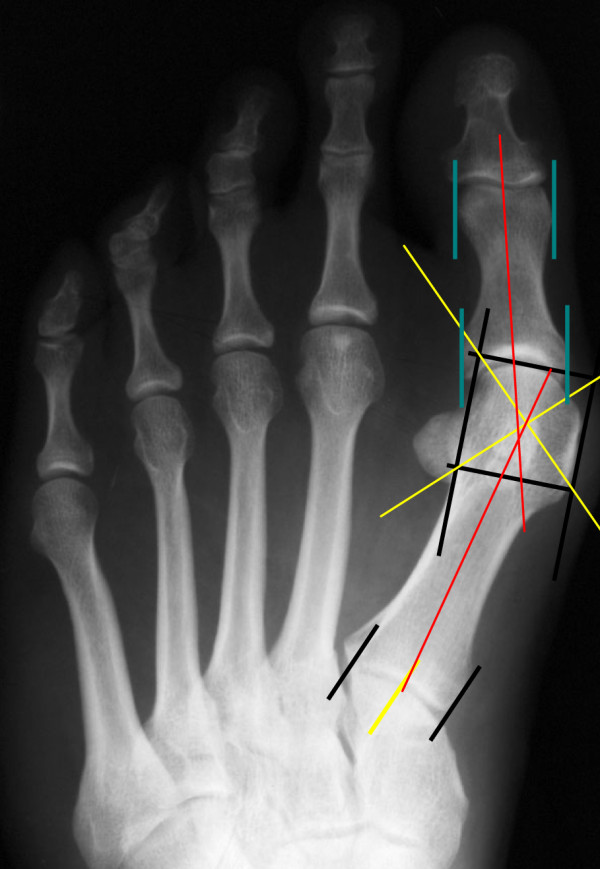
Centre Head – Centre base (CC) measuring method, pre- and postoperative site.